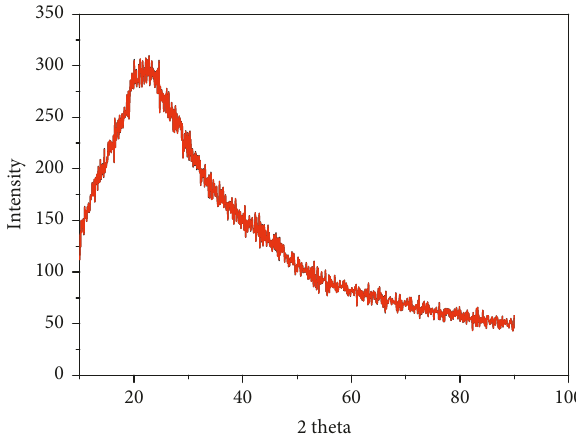
Figure 1: X-ray diffraction (XRD) pattern of Grewia spp. biopolymer.